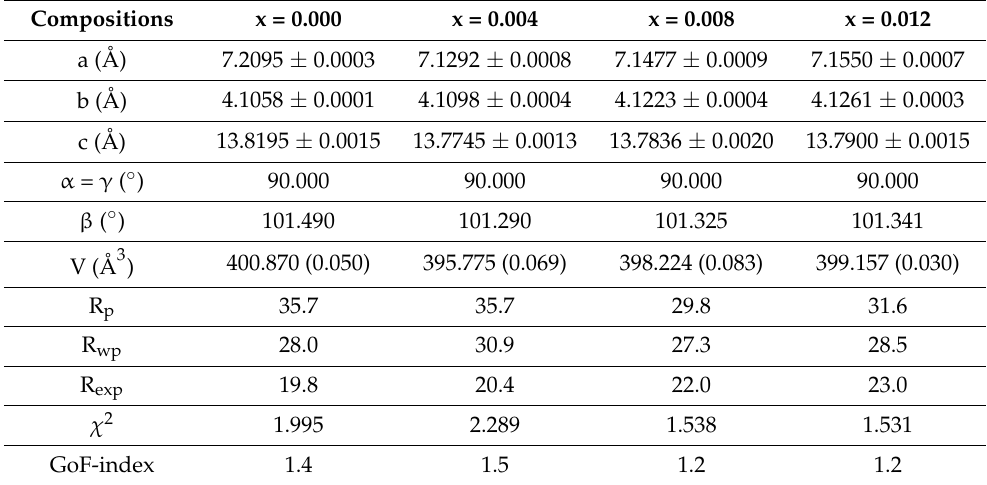
Table 1. Rietveld refined crystallographic parameters and fitting parameters for Cu 2 − x Bi x Se